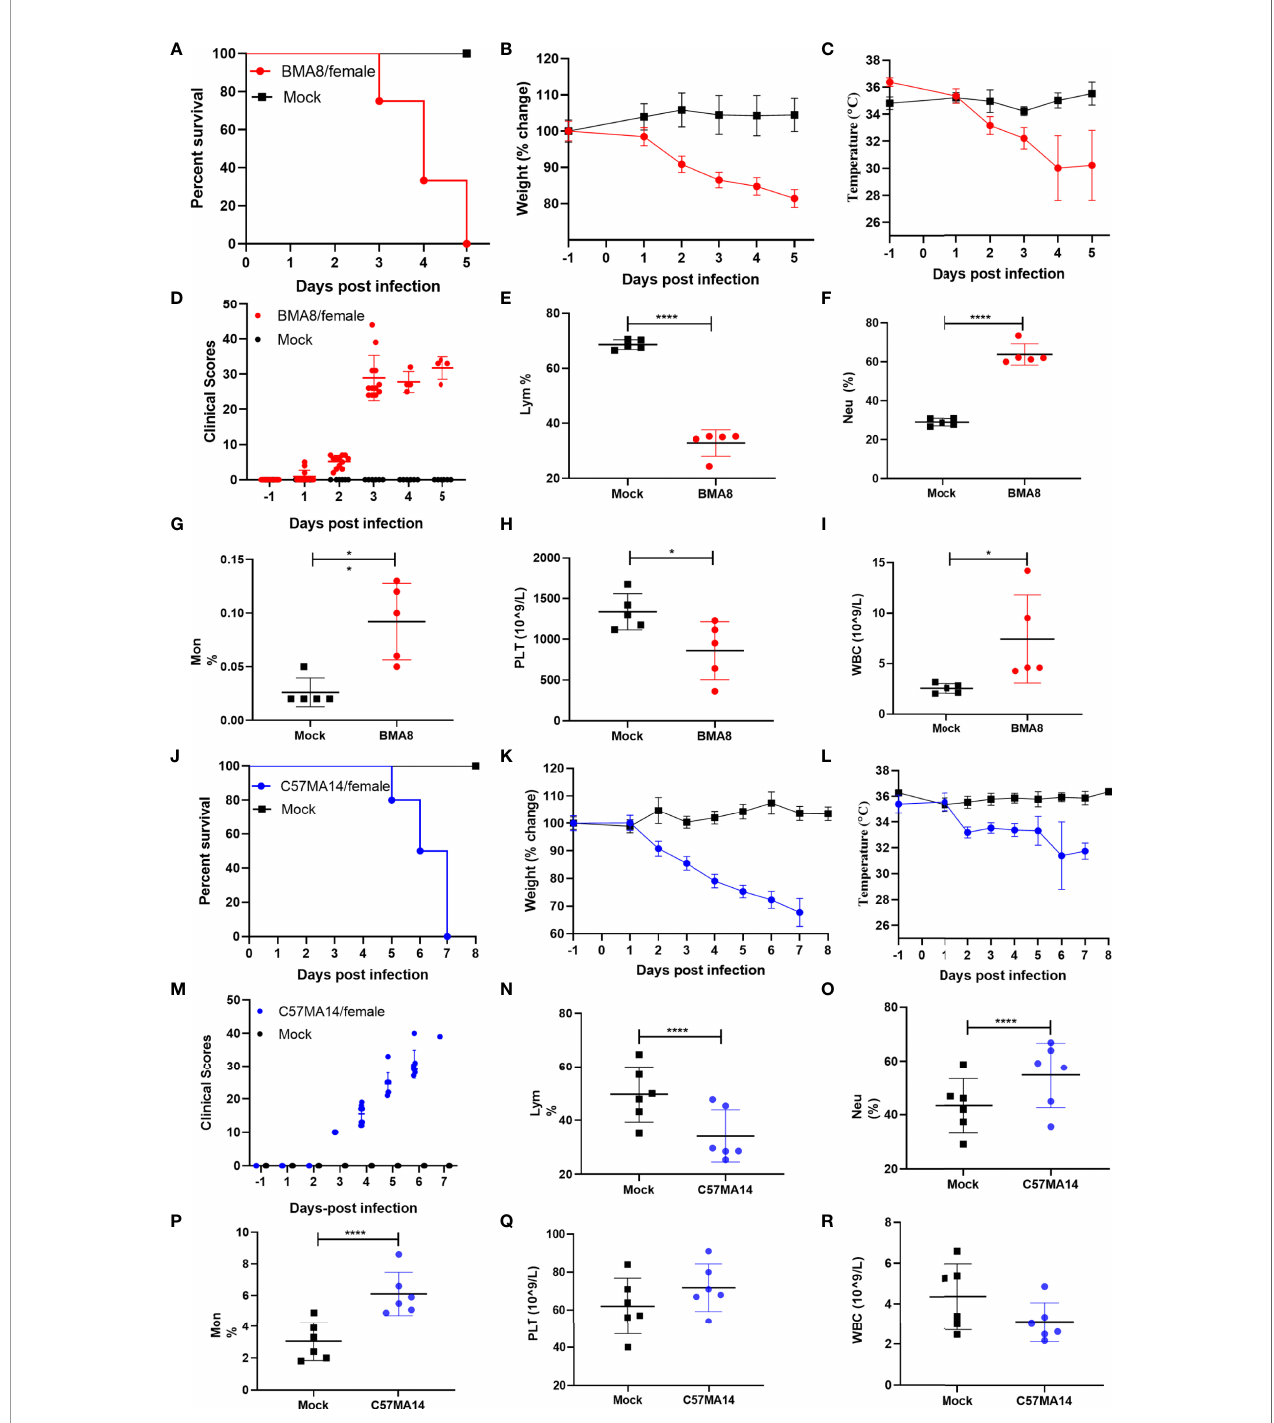
FIGURE 2 | Mouse-adapted strains severe acute respiratory syndrome 2 (SARS-CoV-2) BMA8 and C57MA14 cause severe disease in aged BALB/c and C57BL/ 6N mice. Nine-month-old female BALB/c mice or C57BL/6N mice were mock infected (n = 13) or infected with 50 LD 50 SARS-CoV-2 BMA8 or C57MA14 (n = 13), respectively. The survival rate, weight change, body temperature, and clinical scores of BALB/c mice were monitored daily after SARS-CoV-2 BMA8 infection (A – D) (n = 8) or those parameters of C57BL/6N mice were monitored daily after SARS-CoV-2 C57MA14 infection (J – M) (n = 8). The hematological values of BALB/c mice were analyzed, including lymphocyte percentage (LYM%), neutrophil percentage (Neu%), monocyte percentage (Mon%), platelet (PLT) count, and white blood cell (WBC) count, at 3 dpi after SARS-CoV-2 BMA8 infection (E – I) (n = 5), or those measurement indicators of C57BL/6N mice were also observed daily after SARS- CoV-2 C57MA14 (N-R) (n = 5). Data are presented as mean ± SEM. (*P < 0.05, ****P <